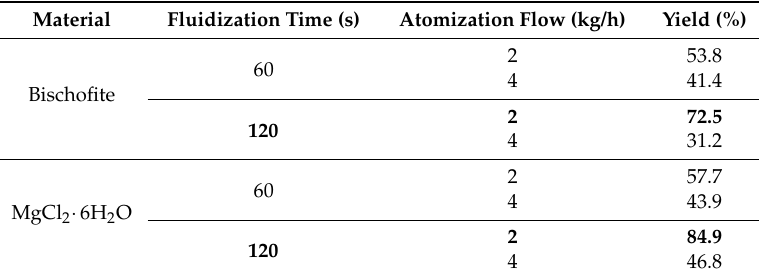
Table 4. Fluidization production